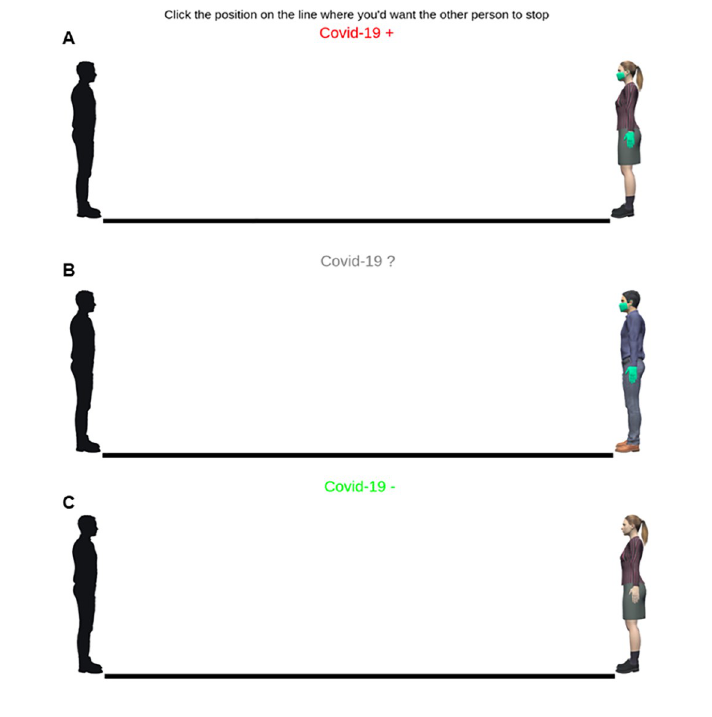
Fig 1. Example of experimental stimuli. Participants were instructed to imagine to be the person on the left side, represented by a gender-matched, black silhouette, and to indicate the distance to the other person (female or male, represented in A-C and B, respectively) that they would feel comfortable keeping. The other person could be wearing protective equipment (A-B) or not (C). The label appearing on the upper part of the screen indicated the COVID-19 test result of the other person: a Positive test result was represented by a “+” and displayed in red (A); an Unknown test result was represented by a “?”and displayed in gray (B); a Negative test result was represented by a “-”and shown in green